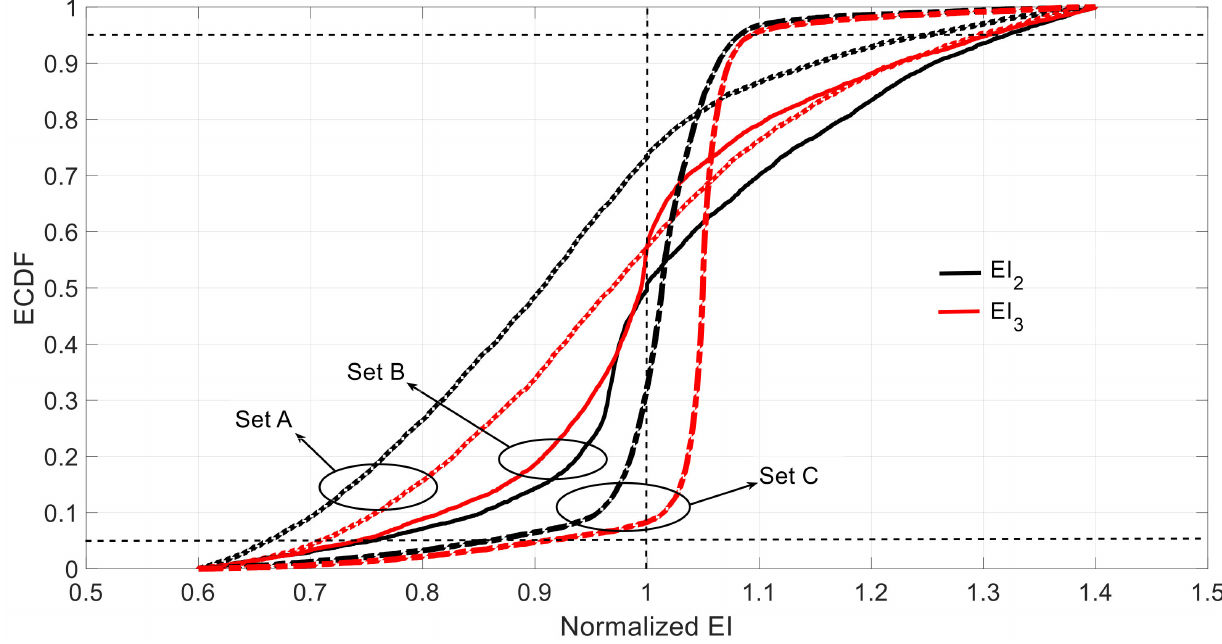
Figure 10. ECDF of estimated under different set considering aleatory and epistemic uncertainties (the vertical dotted line represents the correct value, and the 5 and 95 percentiles are indicated with horizontal dotted lines). Table 6. Statistical data of the estimated EI 2 and EI 3 under different measurement